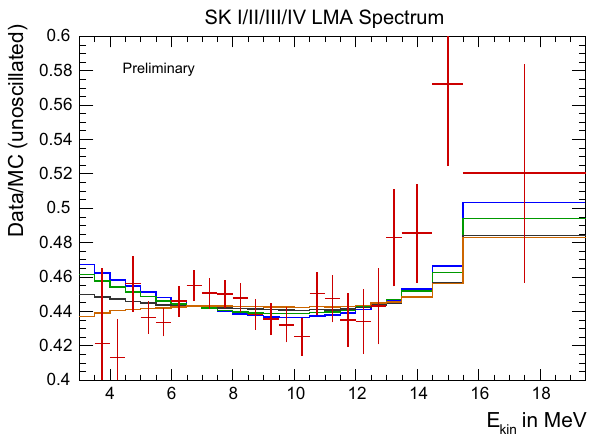
Fig. 15 ThemeasuredenergyspectrumofalltheSuper-Kphasescom- bined. A clear upturn is not seen. The green line is expected from the solar global best and the blue line is that from KamLAND. The black and brown lines are the best fit lines for quadratic and exponential